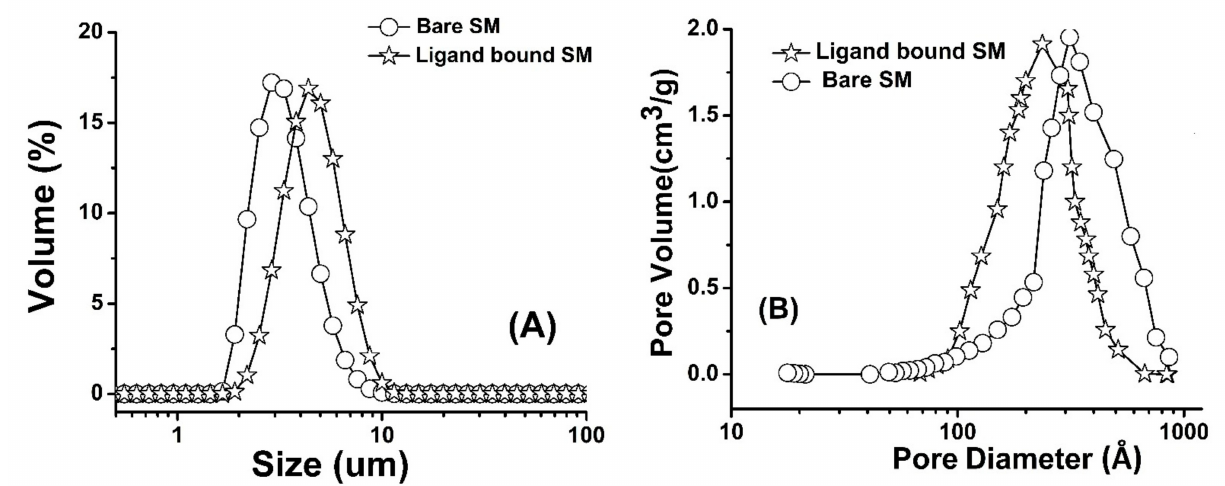
Figure 1. SEM images of bare SM ( A ), chemically modified SM ( B ), broader view of chemically modified SM before adsorption ( C ) and after the adsorption of Pb(II) ( D ).